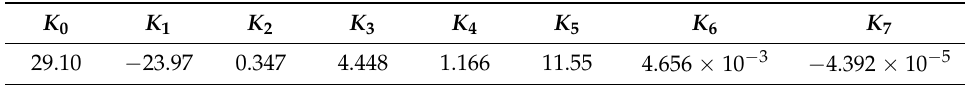
Table 2. The fitted coefficients of Equation